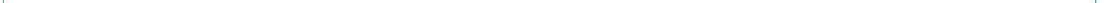
Figure 1: Therapeutic effects of P140 treatment in MRL/lpr mice . A . Long-term effect of P140 peptide on the survival of MRL/lpr mice (69 female mice per group corresponding to eight different experiments performed over 4 years). Pre-autoimmune MRL/lpr mice were treated with either saline or P140 (four doses of 100 µg, given intravenously at 4, 6, 8 and 12 weeks of age). The arrows represent injection timepoints. The median lifespan was 25 weeks in the untreated group vs 35 weeks in the P140-treated group (p <0.0001 using both the log-rank (Mantel- Cox) test and the Gehan-Breslow-Wilcoxon test). B . Effect of autophagy enhancers and blockers on peripheral hypercellularity in MRL/lpr mice. Female MRL/lpr (11–13 weeks old) each received a single intravenous administration of 100 µg P140 in either saline or 10% trehalose, or 100 µg rapamycin or 100 µg hydroxychloroquine (HCQ). The control groups received saline or trehalose only. The number of leukocytes/ml was evaluated by counting cells 5 days later. Each symbol represents one individual mouse (n, number of mice/group). The results are